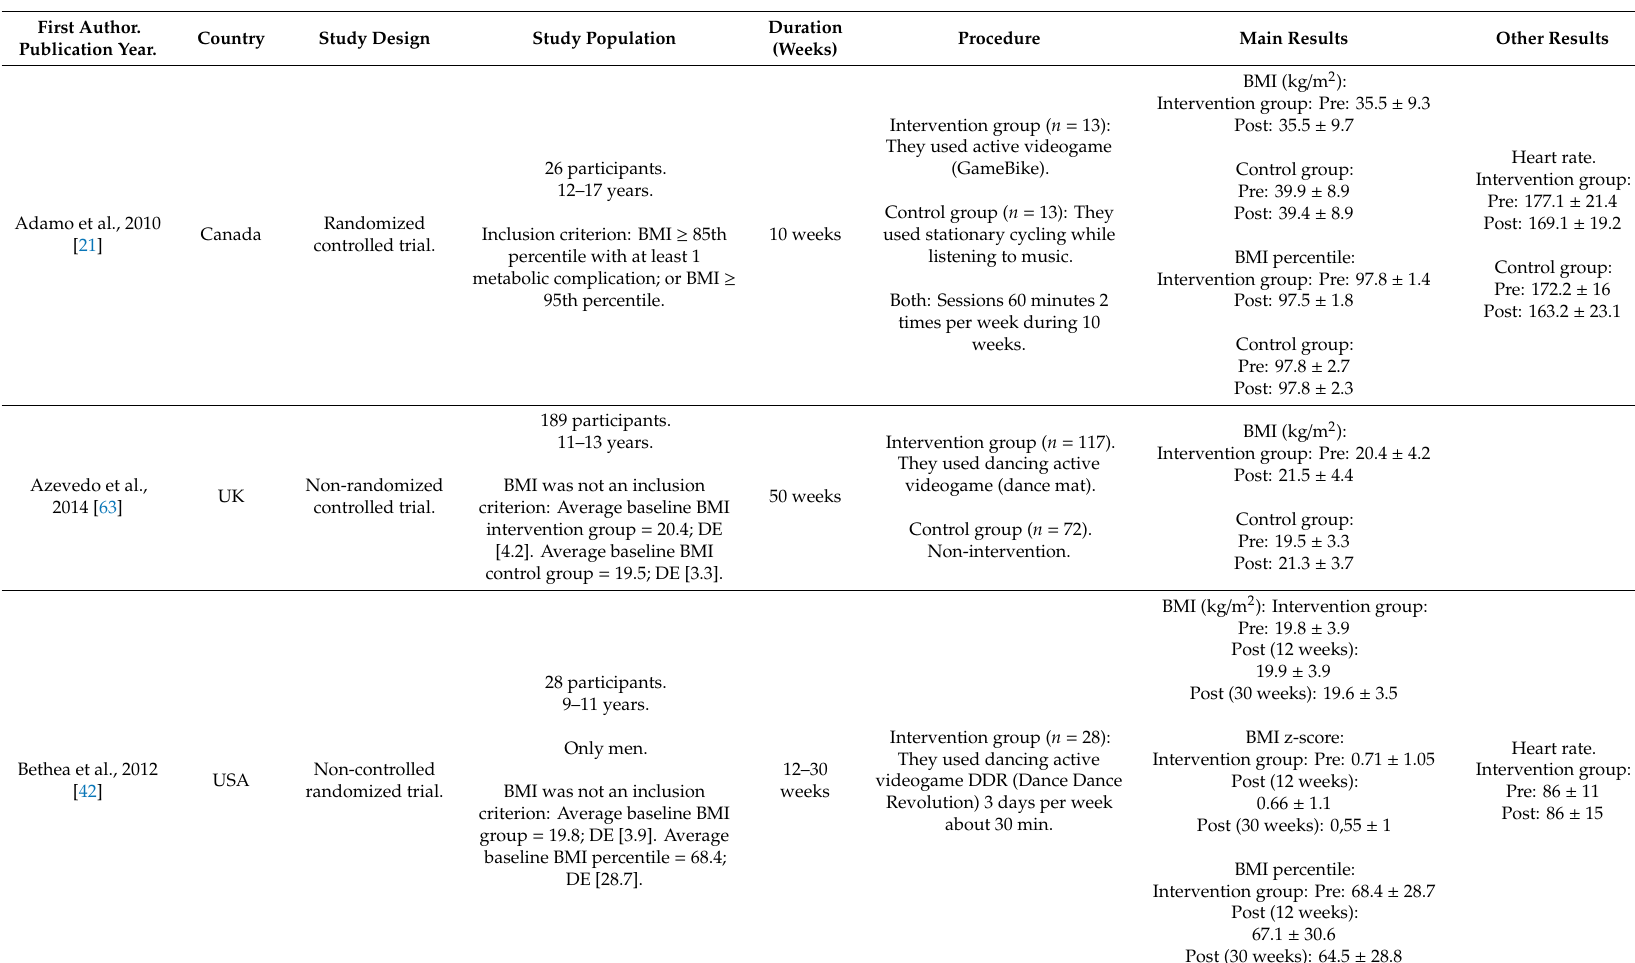
Table 2. Characteristics of included